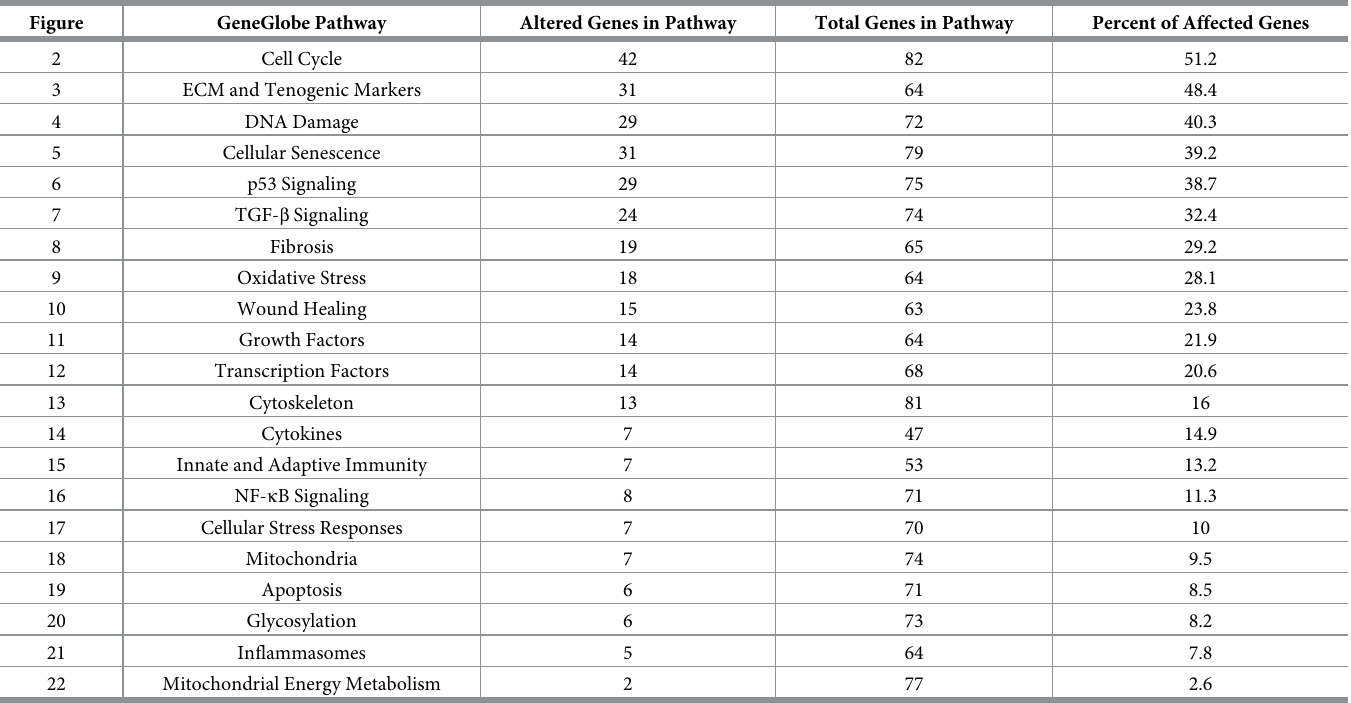
Table 2. Descriptive pathway profiling. Figure